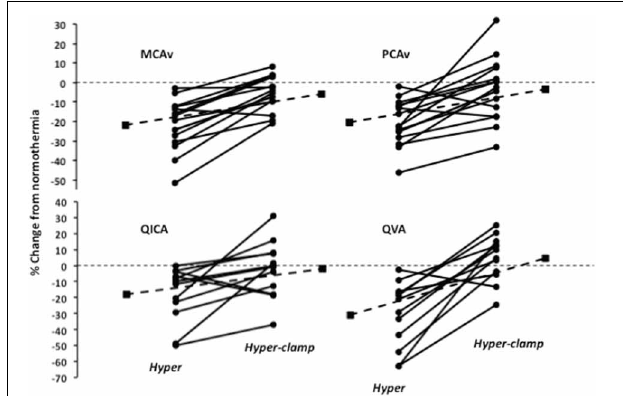
FIGURE 2 | Change in middle cerebral artery blood velocity (MCAv), posterior cerebral artery blood velocity (PCAv), internal carotid artery blood flow (QICA) and vertebral artery blood flow (QVA) following a 2.0 ◦ C rise in esophageal temperature with and without restoration of end-tidal CO 2 . Adapted from (Bain et al.,